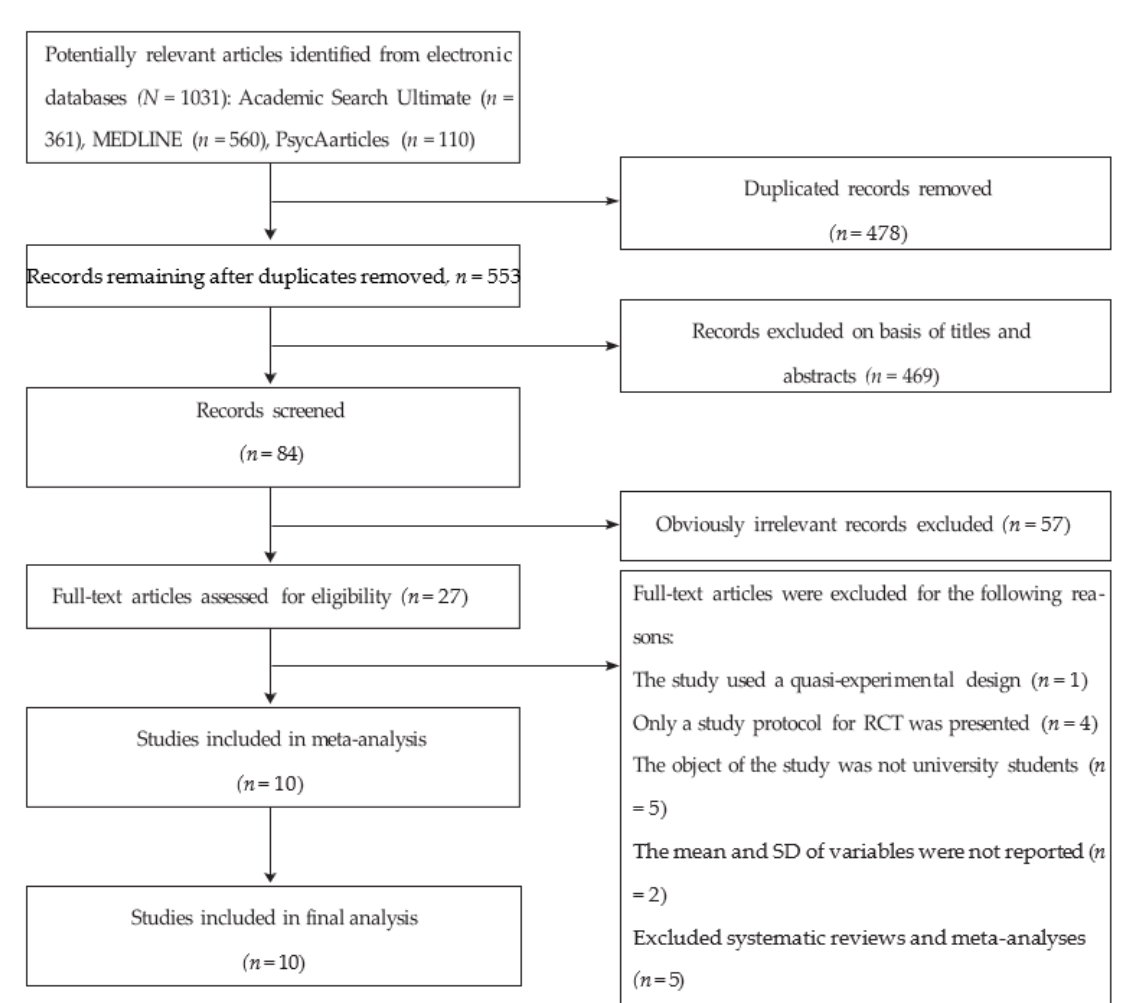
Figure 1. A flow diagram of studies included and excluded (per PRISMA recommendations).